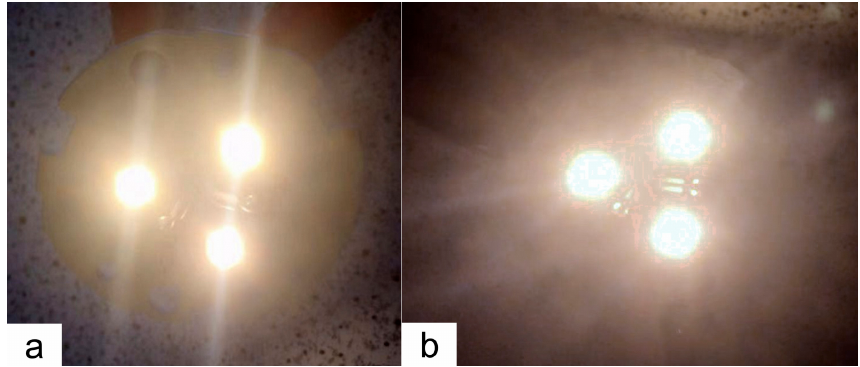
Figure 10. LED head of Sample A under current of 35 mA ( a ) and 200 mA ( b ).